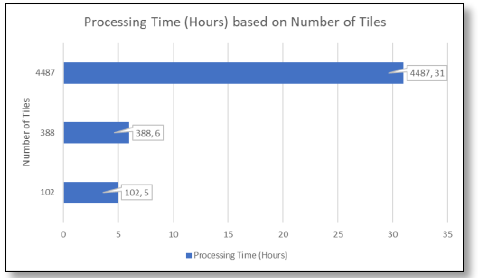
Figure 11: Comparison between processing time based on number of